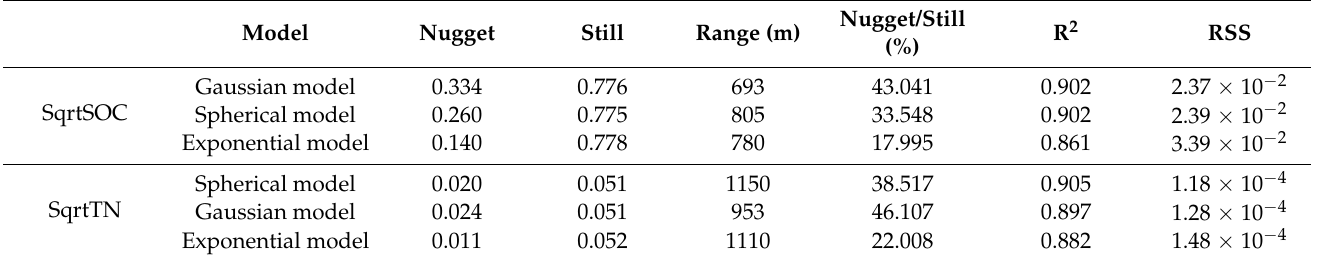
Table 3. Geostatistical parameters of SqrtSOC and SqrtTN in different